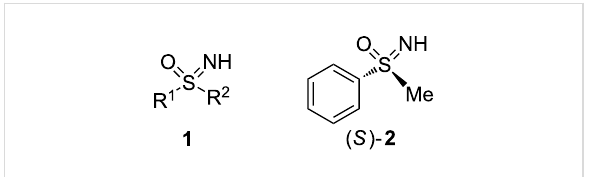
Figure 1: General structure of sulfoximines 1 and one of the enan- tiomers of S -methyl- S -phenylsulfoximine (( S )- 2 ) used in this study.